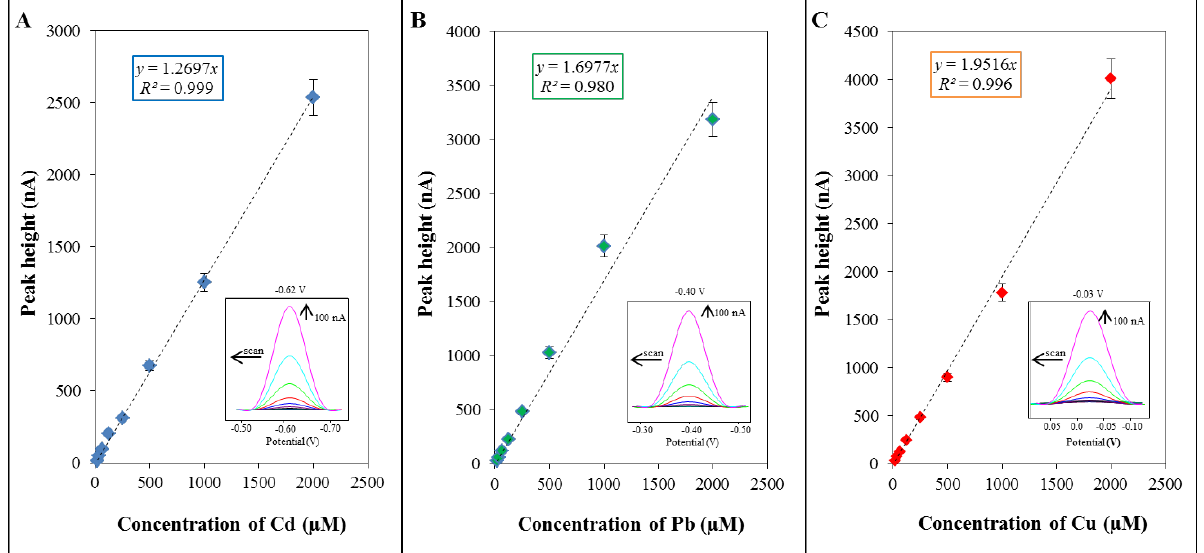
Figure 1. Calibration curves of individual metals determined by differential pulse voltammetry: ( A ) cadmium; ( B ) lead and ( C ) copper. 0.2 M acetate buffer (pH = 5) was used as an electrolyte. The parameters were chosen as it follows: initial potential −1.3 V, end potential 0.2 V, deposition potential −1.15 V, accumulation time 240 s, pulse amplitude 25 mV, pulse time 0.04 s, voltage step 5.035 mV, voltage step time 0.3 s, and sweep rate 0.0168 V/s. The characteristic peaks for cadmium, lead and copper were measured at potentials of −0.62, −0.40 and −0.03 V,